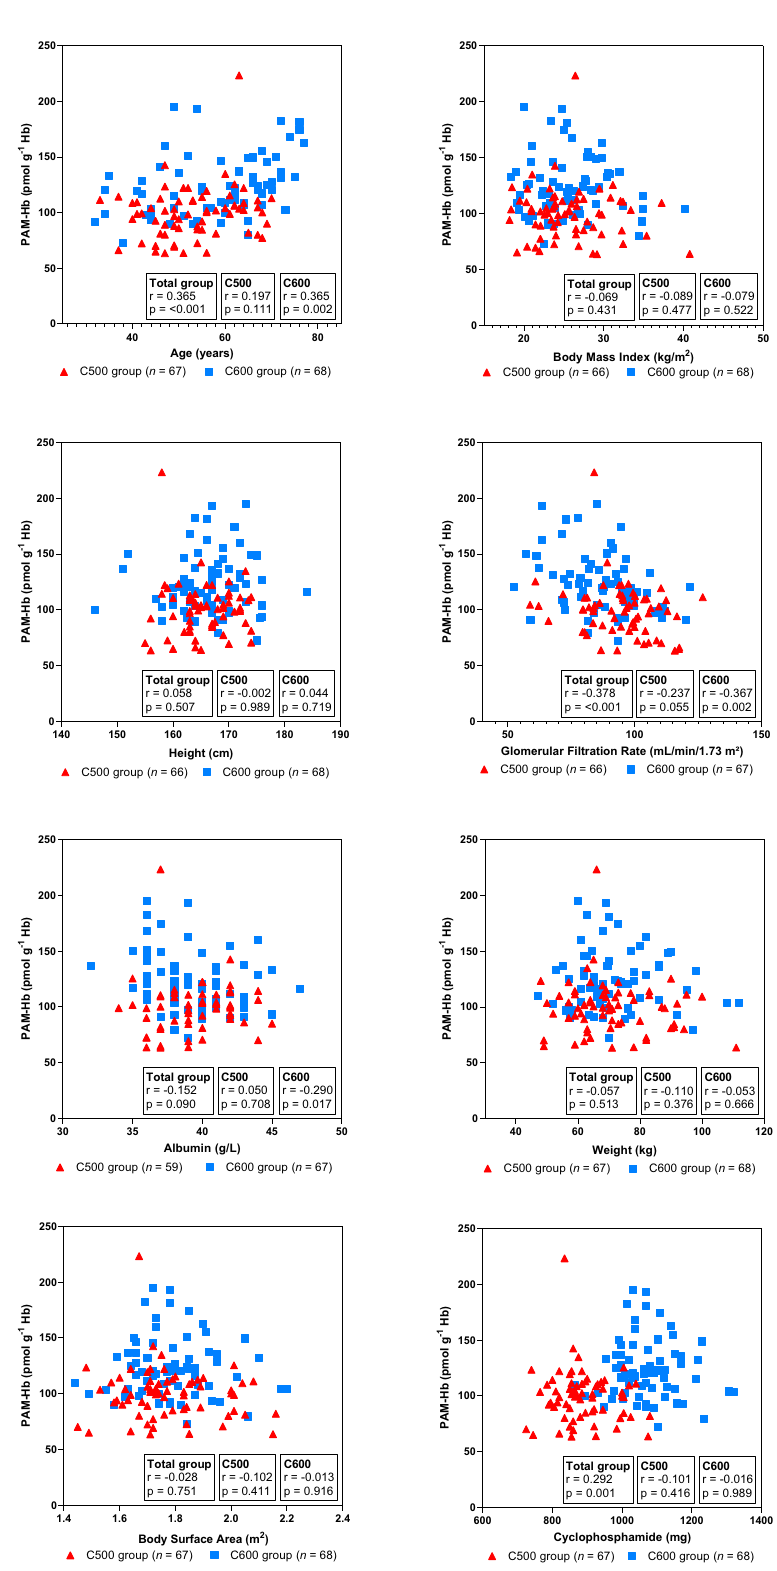
Figure 4. Correlations between phosphoramide mustard-hemoglobin (PAM-Hb) and parameters effecting the cyclophosphamide exposure level in 135 breast cancer patients treated with 500 mg (C500 group) or 600 mg (C600 group) cyclophosphamide per body surface area unit in the first treatment